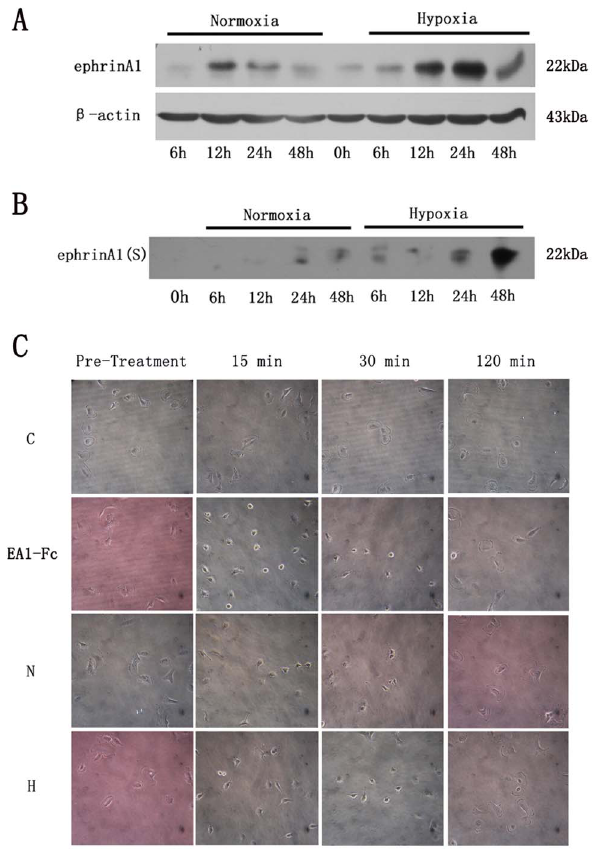
Figure 5. Hypoxia up-regulated ephrin-A1 expression and soluble ephrin-A1 secretion in cancer cells. A: Western blots demonstrating that hypoxia elevated membrane bound ephrin-A1 expression in SCC-9 cells. B: Western blots demonstrating that hypoxia up-regulated soluble ephrin-A1 in supernatants of SCC-9 cells. SCC- 9 cell density at 70–80% confluence was taken as 0 h when fresh culture medium was added. C: Cell rounding assay demonstrating that soluble ephrin-A1 in CM could activate EphA2 in U-251 GBM cells. Ephrin-A1(S), soluble ephrin-A1; N, normoxia conditioned medium group; H, hypoxia conditioned medium group.